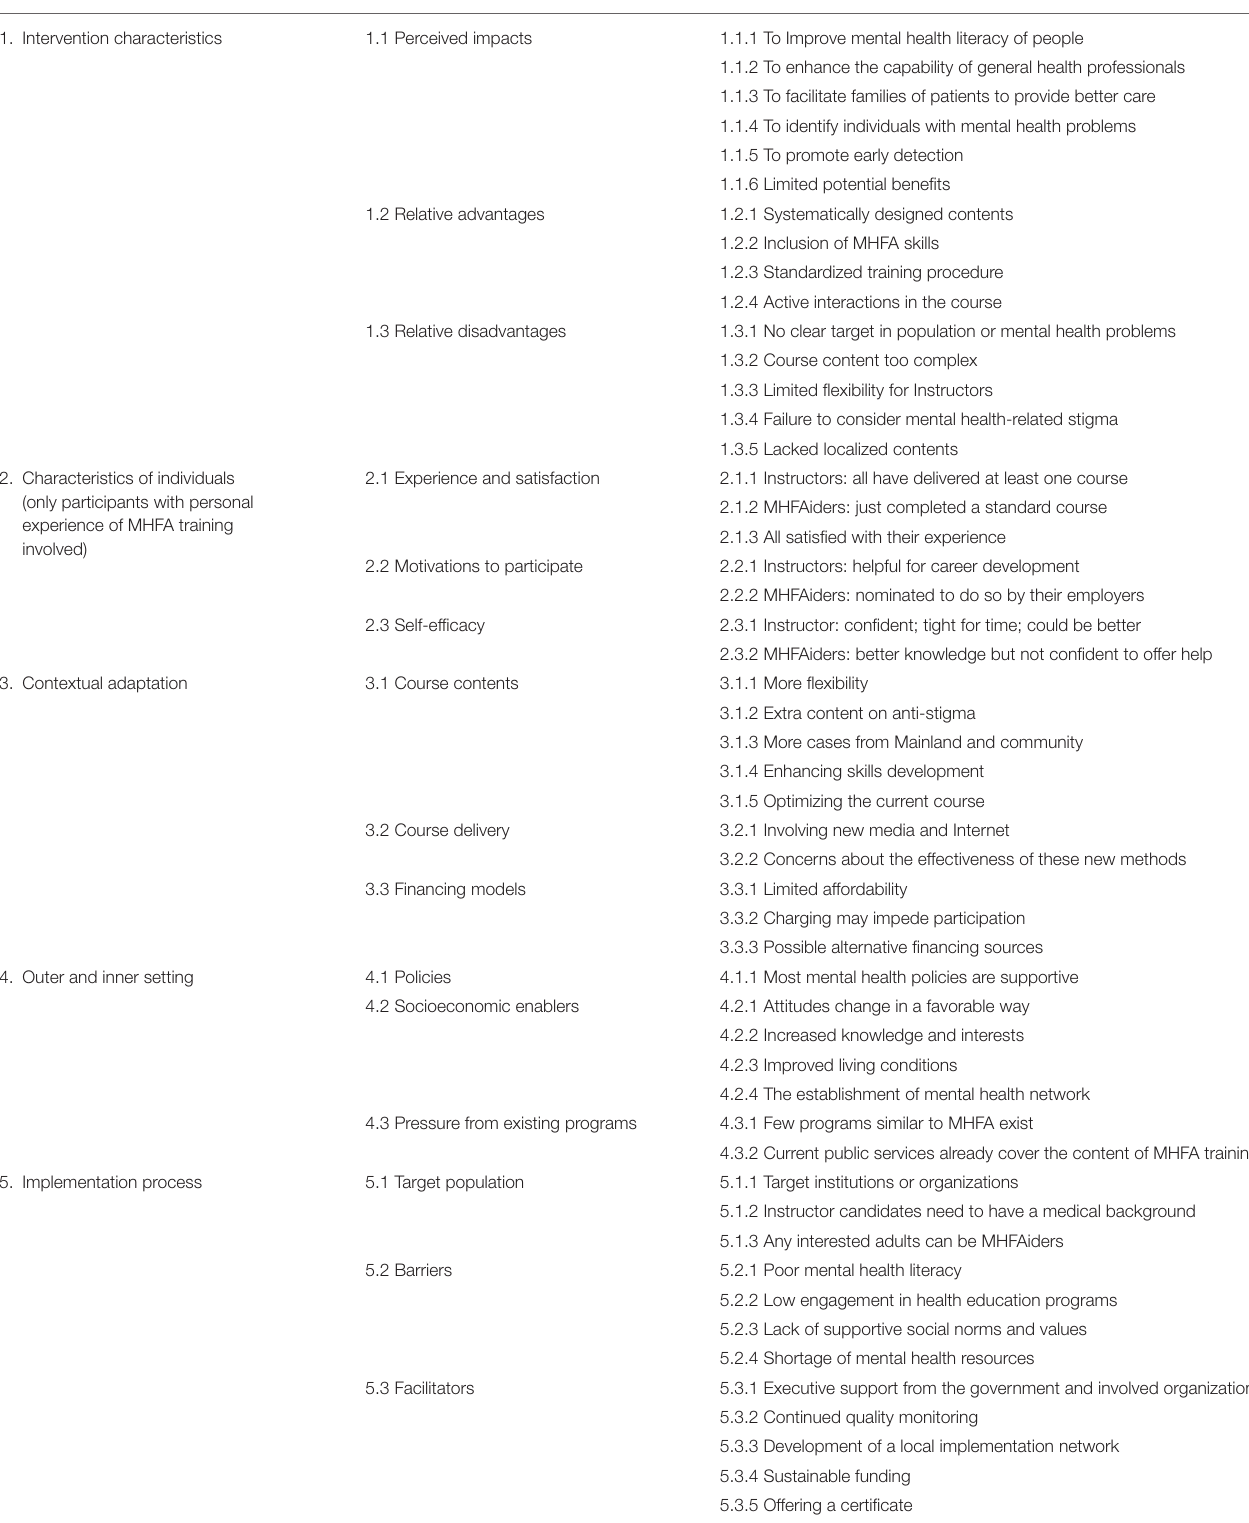
TABLE 3 | Domains, themes, and sub-themes of implementing MHFA in China.